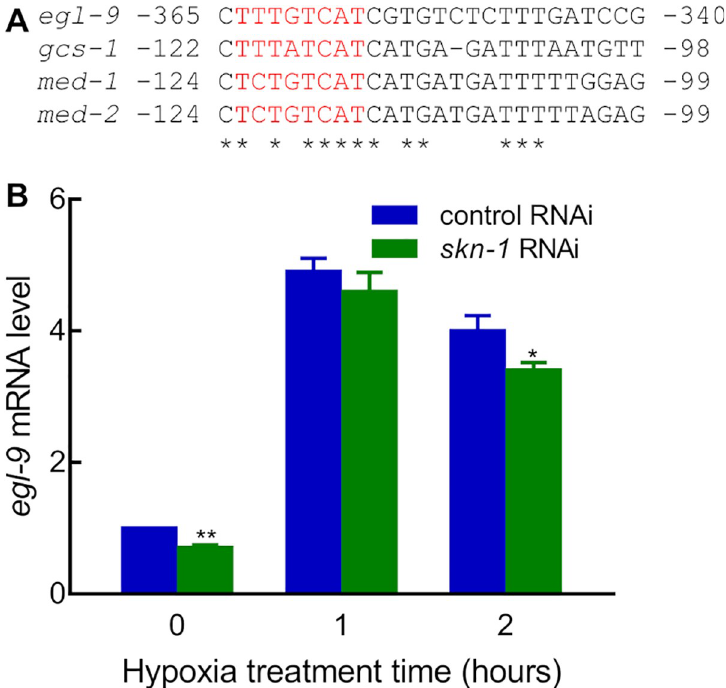
Fig 3. Identification of egl-9 as a potential transcriptional target of SKN-1. (A) Sequence from the egl-9 promoter was aligned with established SKN-1 binding sites in gcs-1 , med-1 , and med-2 . Asterisks identify sequence identities shared by all four promoter regions in this interval, and predicted SKN-1 binding sites are in red. (B) skn-1 RNAi decreased egl-9 mRNA levels. egl-9 mRNA levels were quantitated from three independent real-time quantitative RT-PCR experiments. The values at each time point were normalized to the 0 hour hypoxia control RNAi. Asterisks indicate significant differences between control RNAi and skn-1 RNAi at any given time point. � : p < 0.05; �� : p < 0.01.